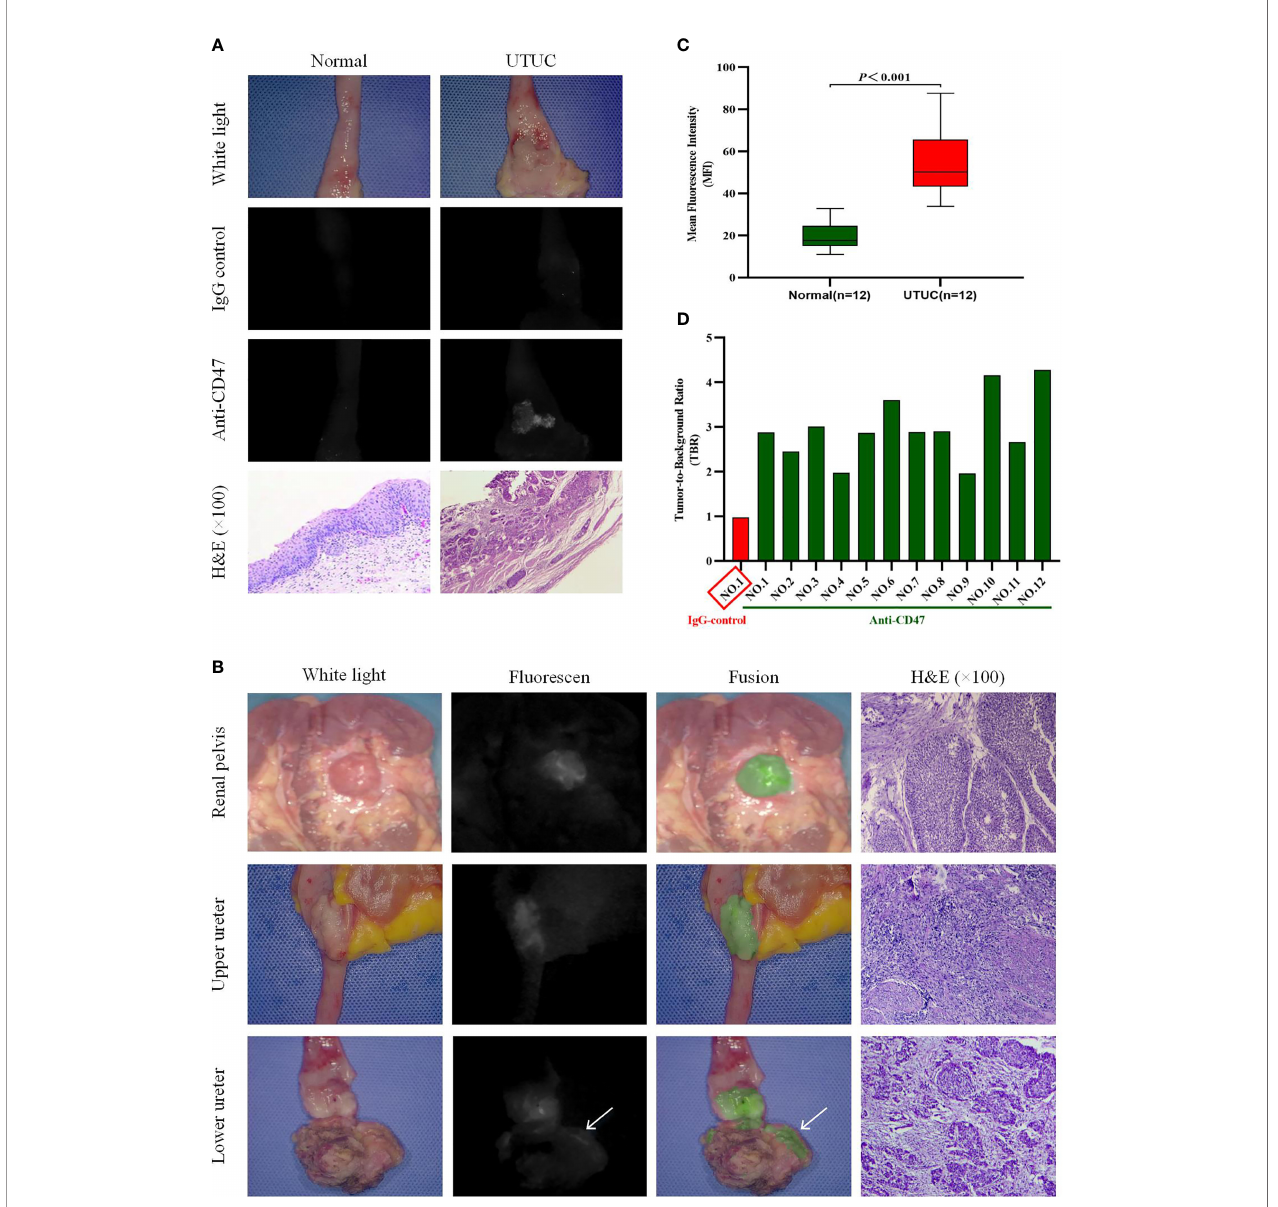
FIGURE 3 | Near-infrared (NIR) molecular imaging of freshly isolated human upper urinary tract urothelial carcinoma (UTUC) with anti-CD47-Alexa Fluor 790. Representative white-light, NIR-light, and fusion images with the relevant hematoxylin and eosin-stained (H&E, ×100) photomicrographs for colocalization of anti-CD47-Alexa Fluor 790 binding and histopathology. (A) One upper urinary tract specimen was incubated and imaged successively with IgG control-Alexa Fluor 790 and anti-CD47-Alexa Fluor 790. White- and NIR-light images of normal urothelium and a noninvasive papillary urothelial carcinoma after incubation with the two antibodies are shown. (B) Representative images of renal pelvis, upper ureter, and lower ureter UTUC after incubation with anti-CD47-Alexa Fluor 790. Positive fl uorescence at the surgical margin (at the arrow) was seen in the lower ureteral tumor. (C) Quantitative mean fl uorescence intensity (MFI) of 12 specimens. MFIs of tumor tissue and normal tissue were 54.67 ± 16.17 and 19.11 ± 6.41 ( P < 0.001), respectively. (D) Tumor-to-background ratio (TBR) data of each